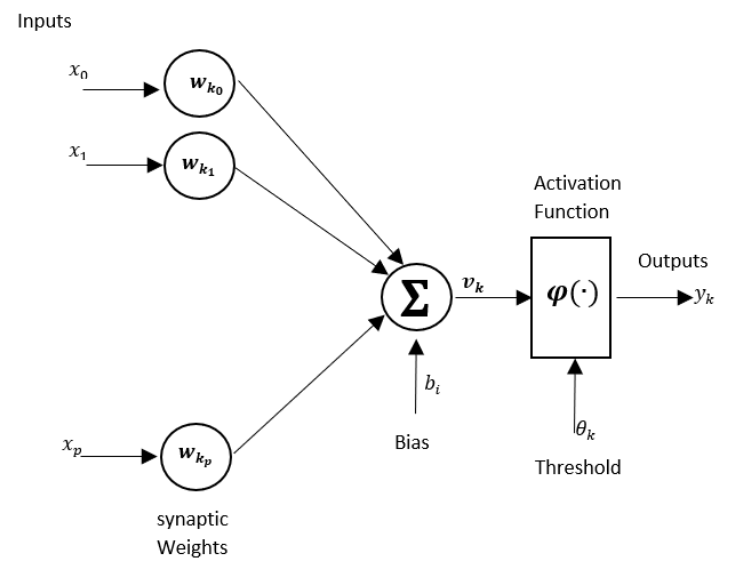
Figure 3. Mathematical model of ANN. A functional model of neurons must consider three basic components. The synapses of the neuron are modeled as weights whose values represent the strength of the connection. Positive weight values represent excitatory connections, and negative values represent negative connections. The next two components model the actual activity within the neuron cell. A summing function sums all inputs modified by their weights. An activation function controls the amplitude of the output of the neuron. The mathematical formulation according to the model of the previous figure is: where b i is the bias, y k is the output, w ki is the weight between the neuron k of the pre- vious layer and neuron i of the current layer and ϕ is the activation function,